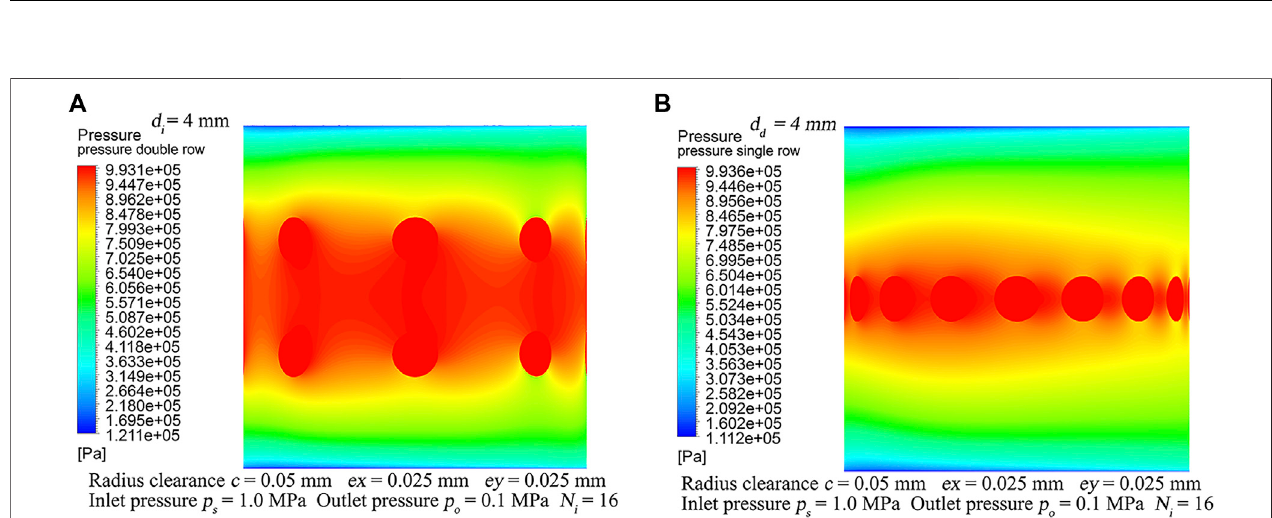
FIGURE 12 | Gas fi lm hydrodynamic and static pressure coupling fi elds, e x = 25 μ m , e y = 25 μ m . (A) Double row. (B) Single row.